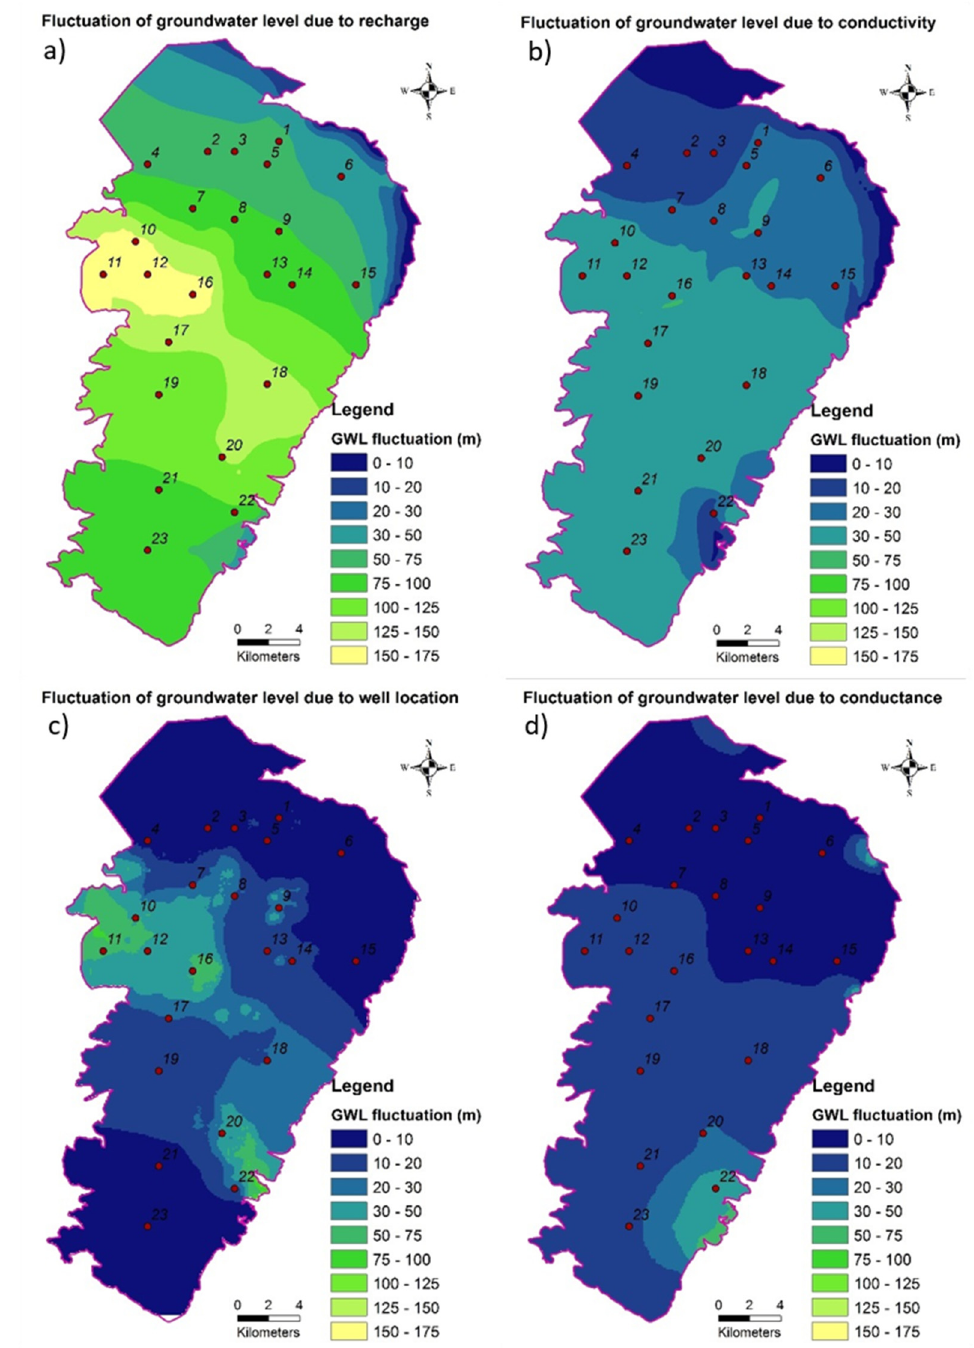
Figure 17. Groundwater fluctuations due to uncertainty in: ( a ) recharge; ( b ) hydraulic conductivity, ( c ) spatial distribution of wells; and ( d ) hydraulic conductance of drain and general head boundary.